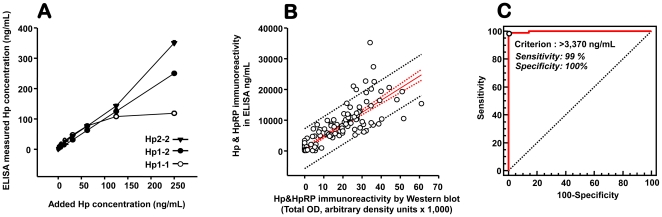
Considerations for determination of cord blood Hp&HpRP immunoreactivity.(A)Demonstration that Hp phenotype impacts on optical density (OD) measured in ELISA. Samples of adult Hp purified from individuals with known phenotype (Hp1-1, 1-2 or 2-2, purchased from Sigma) were diluted progressively in the range of the standard curve and analyzed in ELISA (n = 3 independent observations); (B) Relationship between cord blood Hp&HpRP immunoreactivity measured by ELISA and by Western blot in denatured and reducing conditions (n = 180). The continuous red line represents the linear regression line, the red dotted lines mark the 95% confidence interval and the dotted black lines the 95% prediction interval; (C) ROC analysis which demonstrates the relationship between Hp switch-on pattern and Hp&HpRP cord blood levels measured by ELISA. An ELISA cut-off of 3,370 ng/mL was deemed optimal to discriminate between the Hp switch-on and Hp switch-off pattern by Western blot (n = 180).